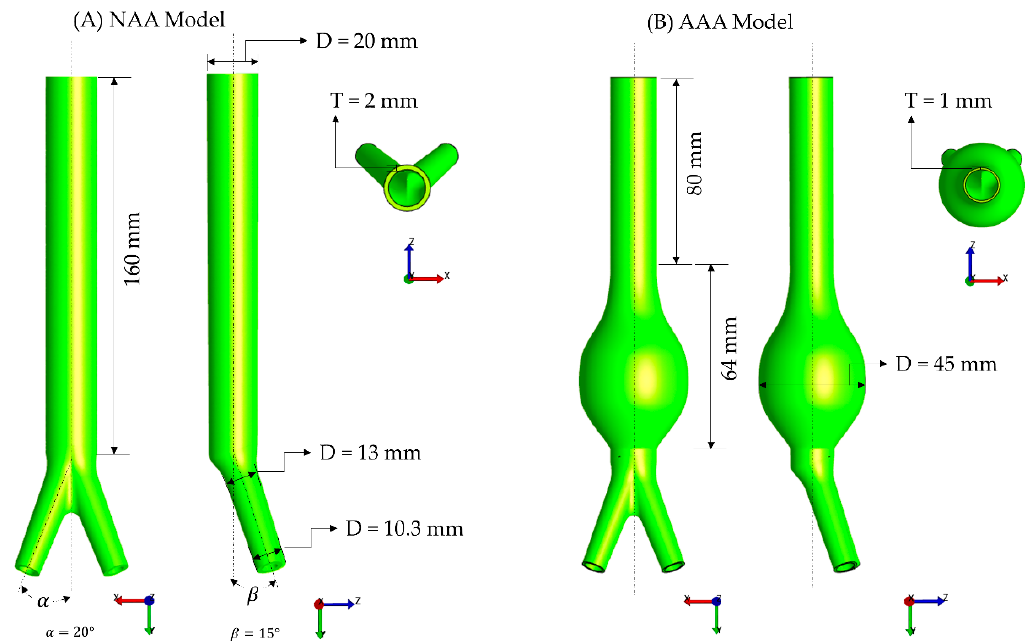
Figure 3. Geometric models and their dimensions for the ( A ) native abdominal aorta (NAA) and ( B ) aneurysmal abdominal aorta (AAA).